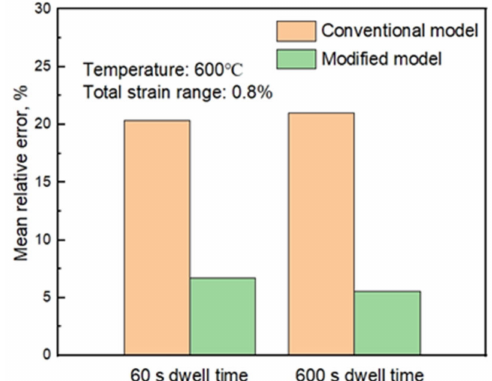
Figure 12. The simulation capability of the conventional and modified models for stress relaxation.